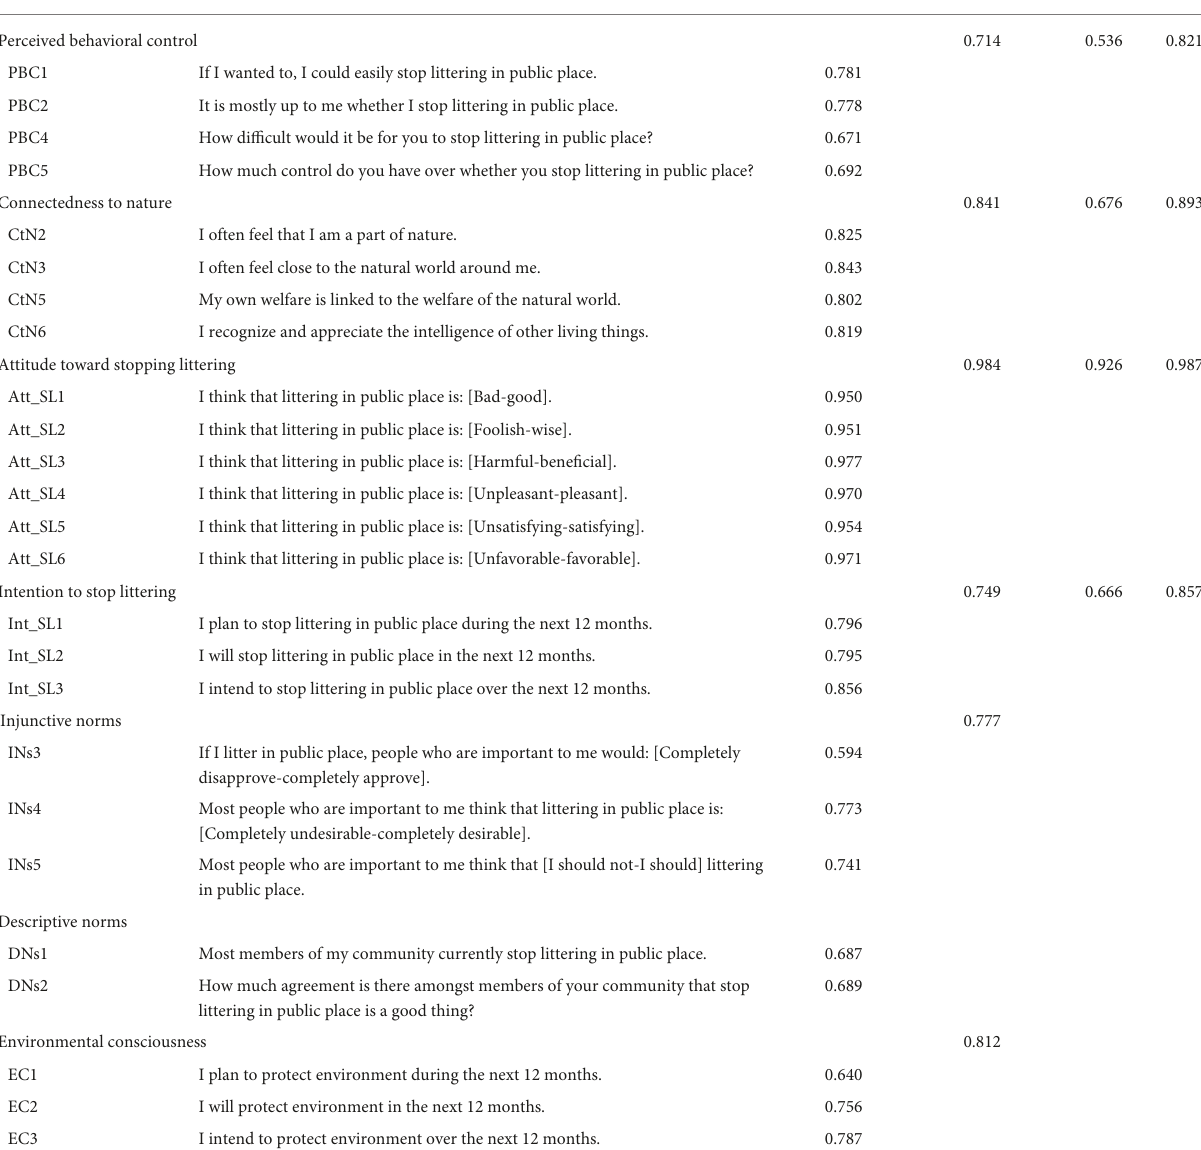
TABLE 2 Results of the measurement